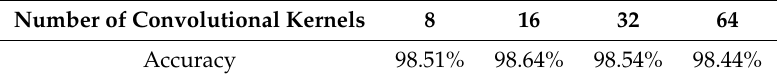
Table 2. Effect of the number of convolutional kernels on the performance of 1D-SCNN.